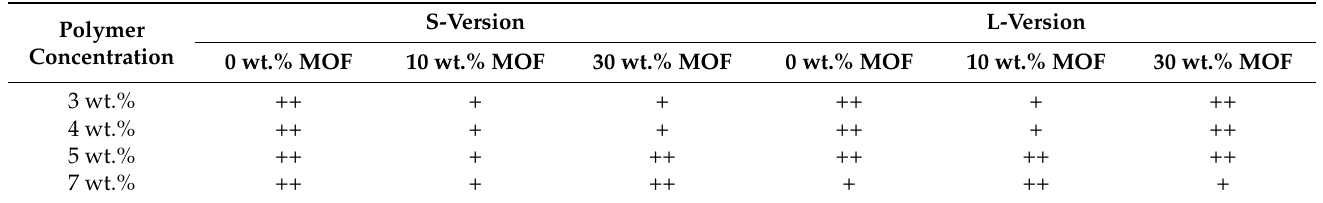
Table 4. Visual assessment of chloroform-based MMMs prepared with different combinations of synthesis parameters 1